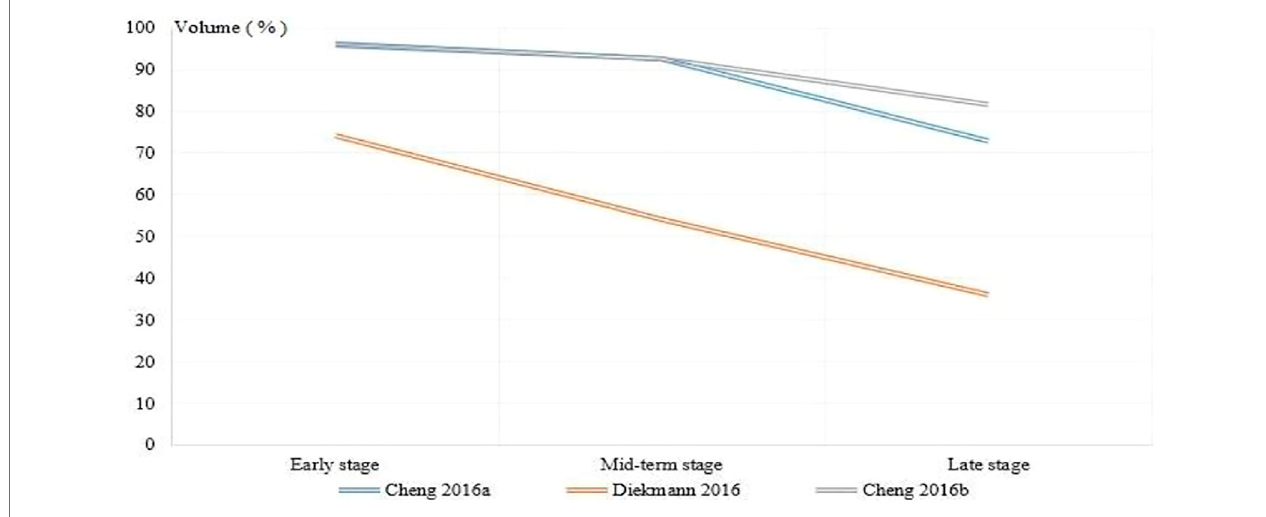
FIGURE 7 | The trend of magnesium and its alloys volume over